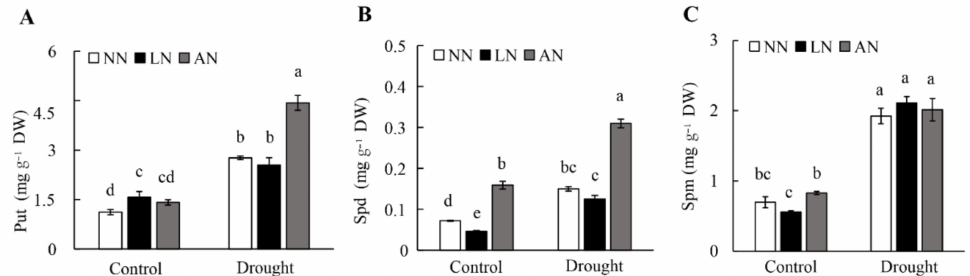
Figure 6. The effects of rhizobia inoculation on free polyamines in response to drought stress. Three- month-old plants were withheld irrigation for 11 days, while unstressed plants were used as a control. Putrescine (Put) ( A ), spermidine (Spd) ( B ), and spermine (Spm) ( C ) were measured in leaves. AN, LN, and NN indicate the plants with active nodules, low-activity nodules, and no nodules, respectively. The presented data are means and standard errors ( n = 3). The same letter above the column indicates no significant difference at p <